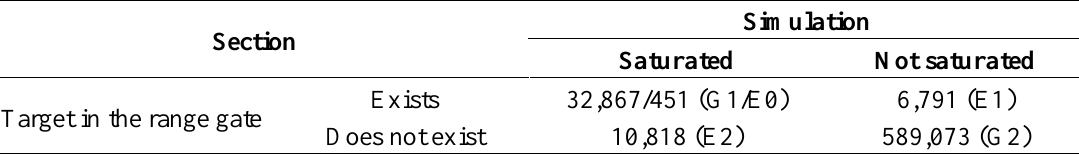
Table 6. Error matrix for the performance assessment of the target detection.